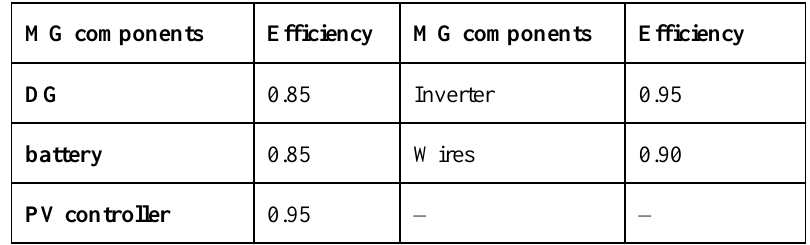
Table 1. Efficiencies for components of